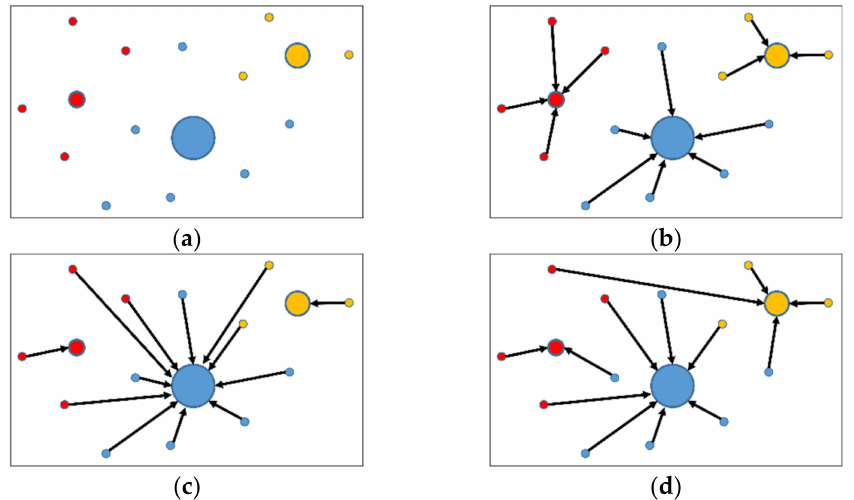
Figure 4. Illustration of the tested assimilation types: ( a ) The imperialist–colony configuration, where the imperialists are the larger points; the size of the imperialist points indicates their fitness; ( b ) local assimilation, where each country moves towards its imperialist owner; ( c ) global assimilation, where most countries move toward the best imperialist; ( d ) free will assimilation, where countries choose which imperialist to move